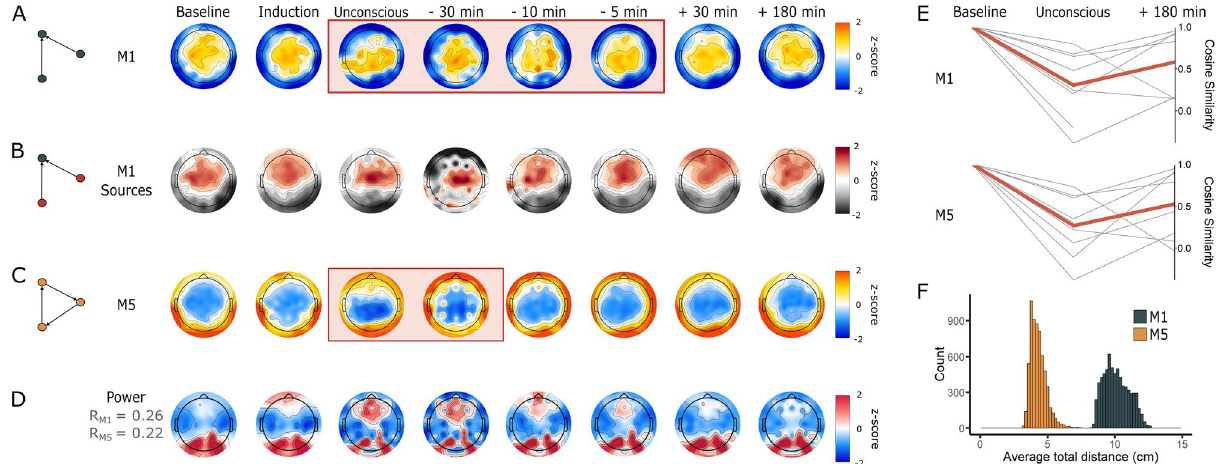
Figure 4. Motif topology across states of consciousness. (A ) and ( C ) Topographic maps of the frequency of participation of nodes in alpha motif 1 (M1) and motif 5 (M5) across the eight analysis epochs. Orange rectangles highlight the epochs that are significantly distinct from Baseline ( p < 0.05). The colormap represents the Z-score comparing the frequency of motif participations for each electrode to the distribution of frequency of motif participation for all electrodes in the network. ( B ) Topographic maps depicting the distribution of nodes acting as sources of information flow (i.e. nodes that have a phase-lead relationship with regards to the other nodes within the motif), in every instance of motif 1 within the EEG network, across the eight time points of the anesthetic protocol. The colormap represents the Z-score comparing the total number of times a given node is a source, compared to the distribution of this feature for all nodes in the network. ( D ) Alpha power topographic maps across the eight analysis epochs. There is a significant, small-to-medium positive correlation between alpha power the frequency of motif 1 (R = 0.26, p < 0.001) and motif 5 (R = 0.22, p < 0.001). E) Differences in cosine similarity values between Baseline, Unconscious, and 180 min post-recovery of responsiveness. Thin grey lines depict single participants, while the thicker red line depicts average cosine similarity value across all participants. ( F ) Across participants and epochs, nodes participating in motif 1 form longer-range connections than those participating in motif